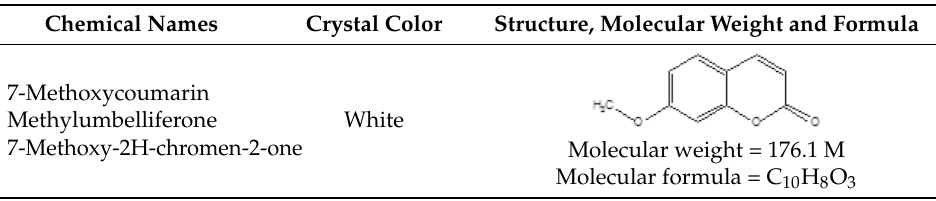
Table 1. General information on 7-methoxycoumarin isolated from F. umbellata .